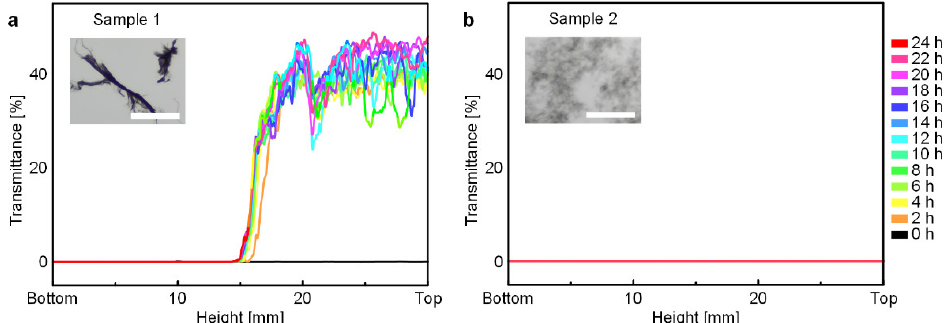
Figure 1. Turbiscan transmittance data of CNT/ m -cresol dispersions. ( a ) The change of transmittance of Sample 1 (without the ultrasonication treatment) for 24 h. The optical microscopy image (inset) shows undispersed large CNT bundles. ( b ) The change of transmittance of Sample 2 (with the ultrasonication treatment) for 24 h. The optical microscopy image (inset) shows that large CNT bundles were de-bundled to small CNT bundles. Scale bars of inset optical microscopy images: 100 μm.